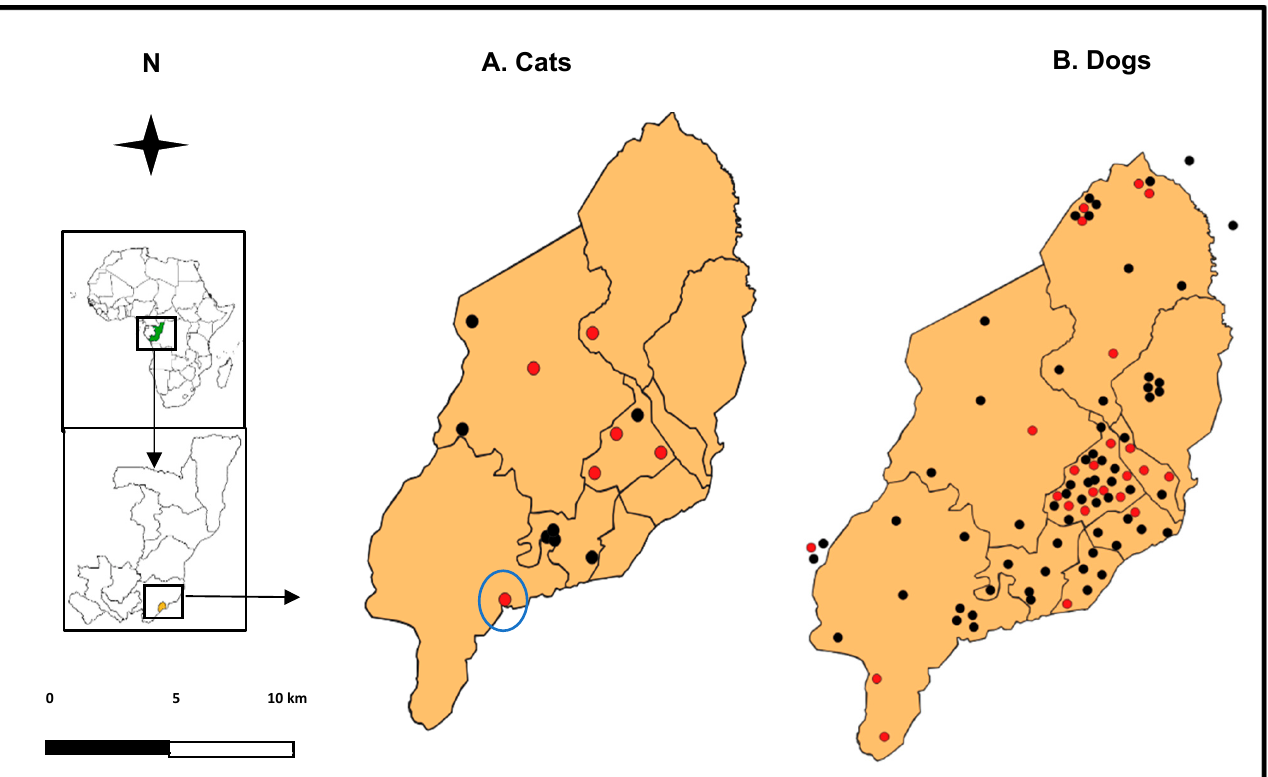
Figure 1. Maps of Brazzaville (RoC) showing the distribution of households where cats ( A ) and dogs ( B ) were sampled. Red and black dots represent the pets that tested positive and negative, respectively, for SARS-CoV-2. The cat with a putative recombinant variant is highlighted with a blue circle. Map data source: www.arcgis.com accessed on 3 February 2022.